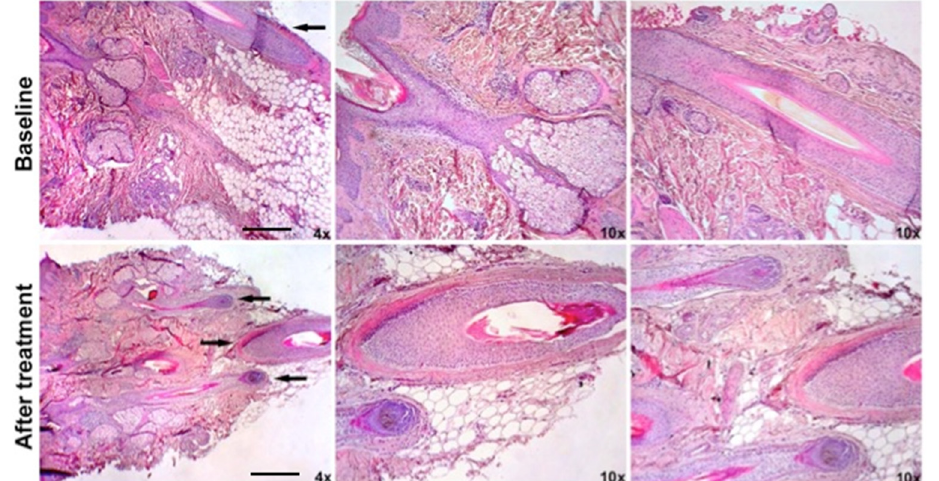
Figure 3. Microscopic evaluation of pattern hair loss after micro-grafts application. Representative microphotographs of scalp biopsies at baseline (time 0) and at 44 weeks after the micro-grafts treatment. Arrows show hair follicles. Magnification 4× and 10×.